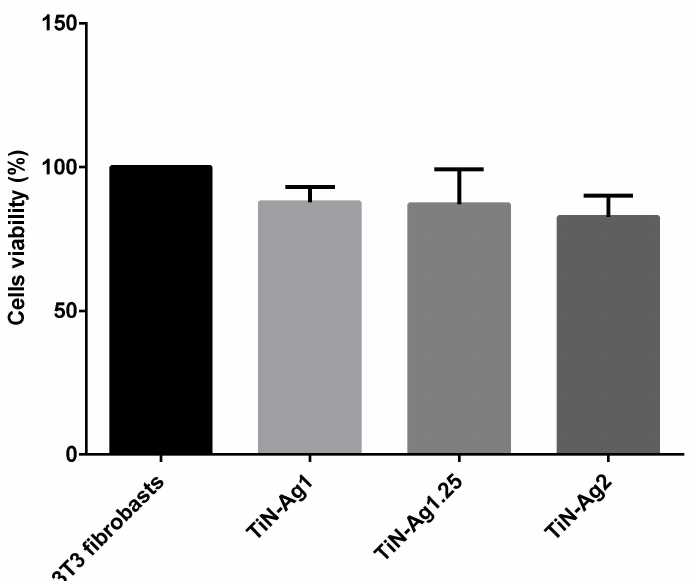
Figure 5. Cell viability evaluated by the MTS assay to S.S. solution after 24 h of contact with the respective samples. Fibroblasts 3T3 are the